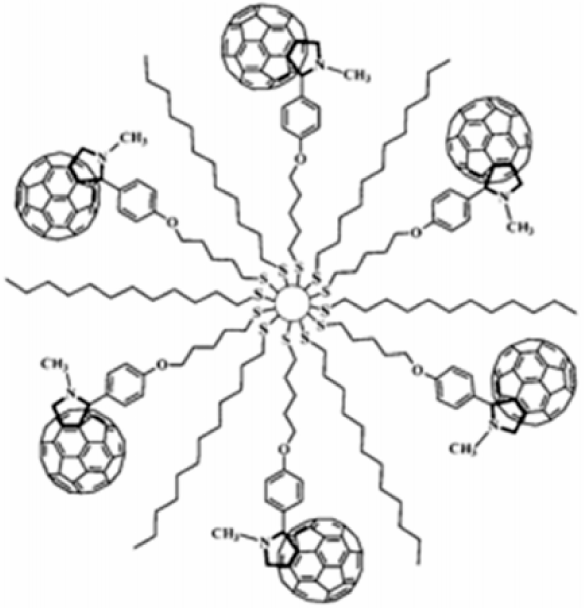
Figure 2. Scheme of a fullerene thiol-functional Au NP example. Reproduced with permission from ACS, 2002